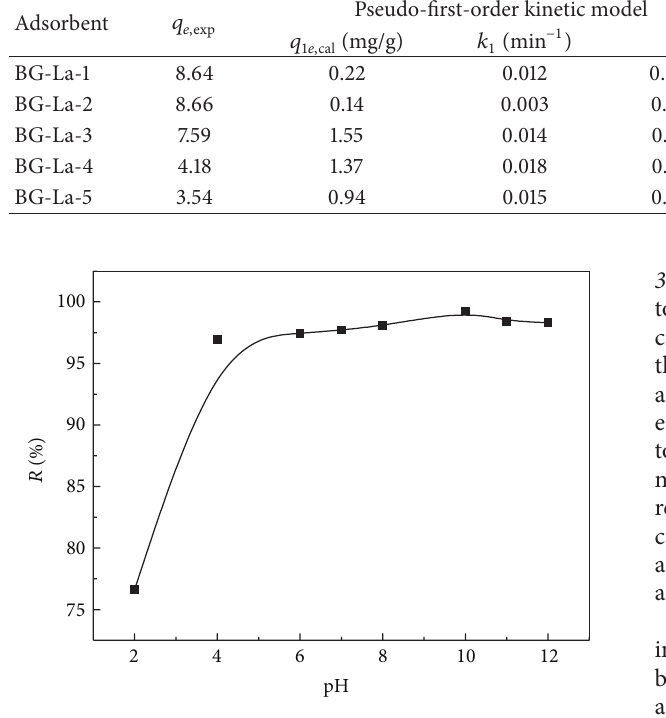
Figure 6: Influence of solution initial pH of